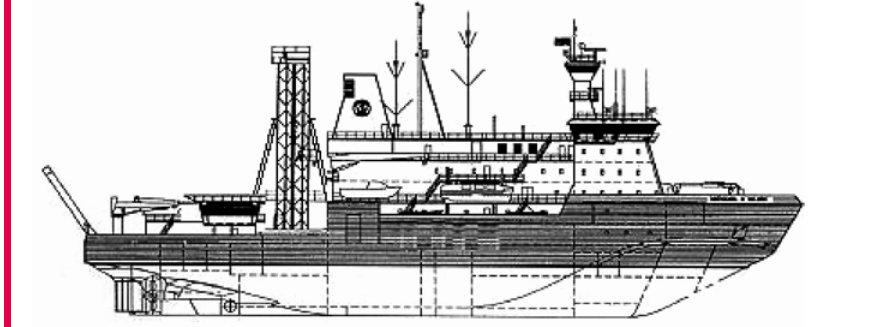
Cornwall.Figure 3. Schematic showing a drill rig placed over the moonpool on the Nathaniel B. Palmer